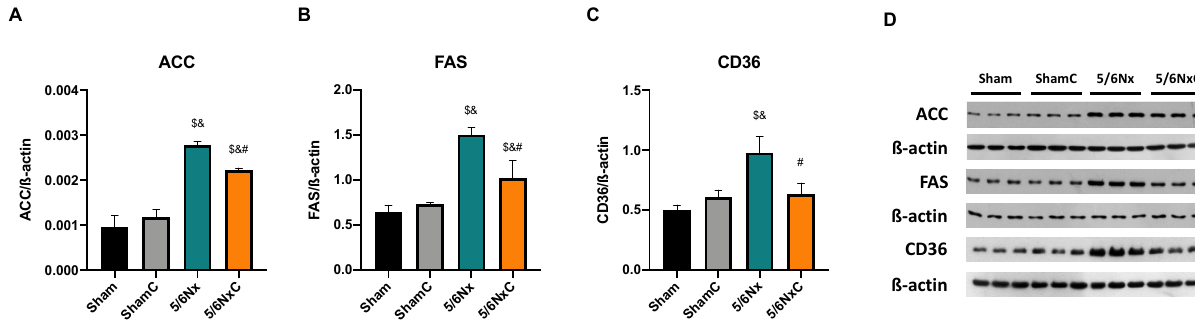
Figure 4. Kidney fatty acids synthesis and storage-related protein abundance in the four groups of rats studied: Sham, Sham + curcumin (ShamC), five-sixths nephrectomy (5/6Nx), and 5/6Nx + curcumin (5/6NxC). ( A ) Acetyl CoA carboxylase (ACC), ( B ) Fatty acid synthase (FAS). ( C ) Fatty acid receptor cluster of differentiation 36 (CD36), and ( D ) representative images of western blot. β -actin was used as a loading control. One-way analysis of variance (ANOVA), posthoc Fisher´s Least significant difference (LSD), Mean ± SD, n = 3, $ p < 0.05 vs. Sham, & p < 0.05 vs. ShamC, # p < 0.05 vs. 5/6Nx.